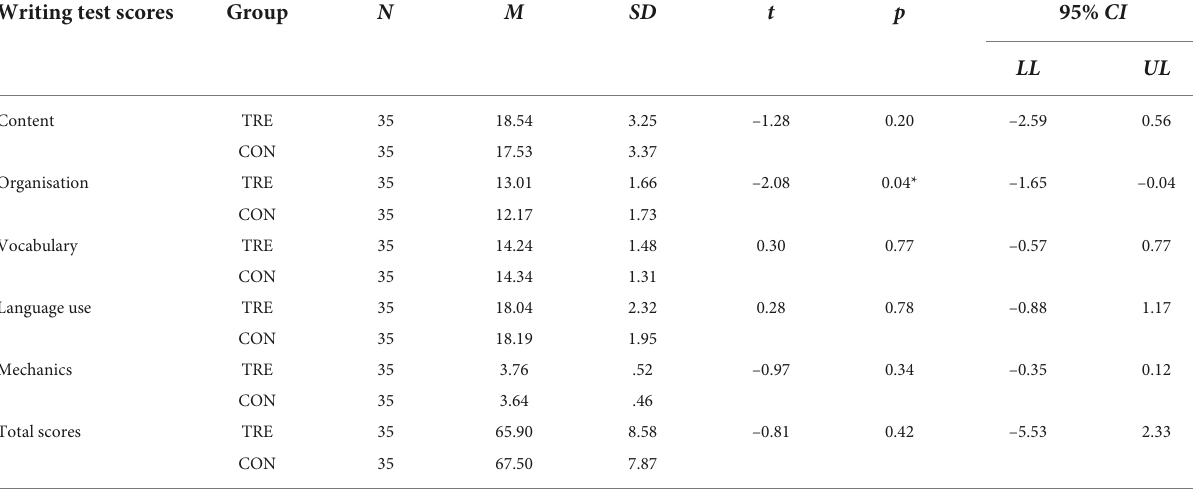
TABLE 4 Descriptive statistics and independent samples t -tests of writing test scores for the control and treatment groups in the pre-test. Writing test